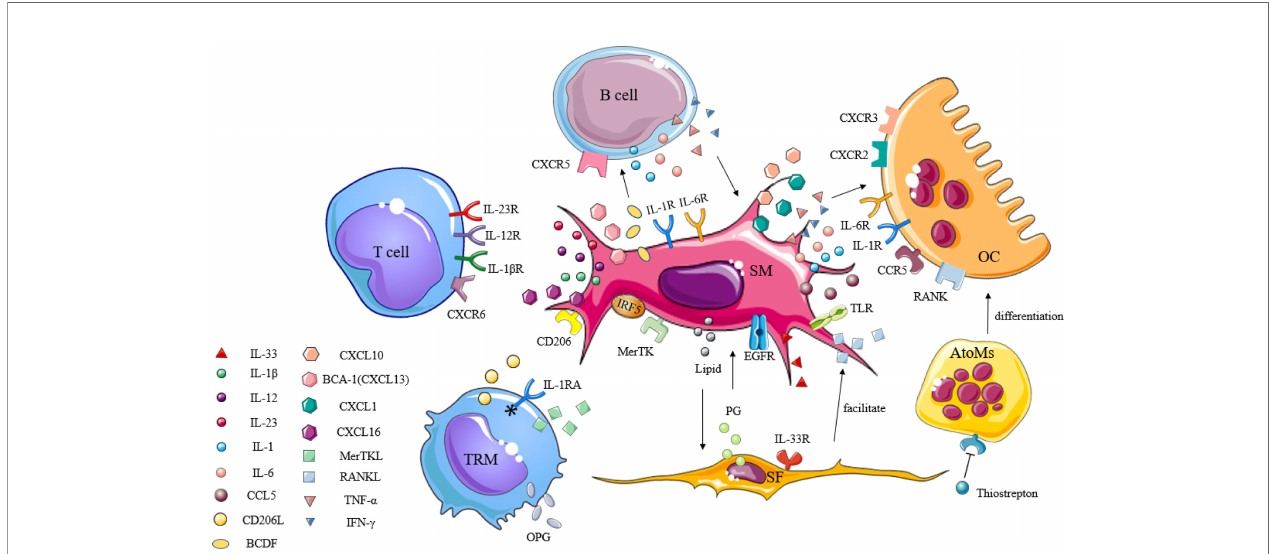
FIGURE 2 | The immunogenic role of synovial macrophages in in fl ammatory arthritis. Synovial macrophages interact with other immune cells through cytokines, chemokines, and in fl ammatory mediators to promote the activation, proliferation, and differentiation of lymphocytes, synovial fi broblasts, and osteoclasts in the synovium. TRM, tissue-resident memory T; SM, synovial macrophage; SF, synovial fi broblast; OC, osteoclast; AtoMs, arthritis-associated osteoclastogenic macrophages; IL-1RA, IL-1 receptor antagonists; IL-1 b R, IL-1 b receptor; IL-12R, IL-12 receptor; IL-23R, IL-23 receptor; IL-1R, IL-1 receptor; IL-6R, IL-6 receptor; IL-33R, IL-33 receptor; CD206L, CD206 ligand; CXCL, C-X-C motif chemokine ligand; CXCR, C-X-C motif chemokine receptor; CCL, C-C motif chemokine ligand; CCR, C-C motif chemokine receptor; TNF- a , tumor necrosis factor- a ; IFN- g , interferon- g ; OPG, osteoprotegerin; MerTK, tyrosine-protein kinase Mer; IRF5, interferon regulatory factor 5; BCA-1, B-cell-attracting chemokine; BCDF, B-cell differentiation factor; TLR, toll-like receptor; RANK, receptor activator of nuclear factor kappa- B; RANKL, receptor activator of nuclear factor kappa-B ligand; EGF, epidermal growth factor; EGFR, epidermal growth factor receptor; PG,